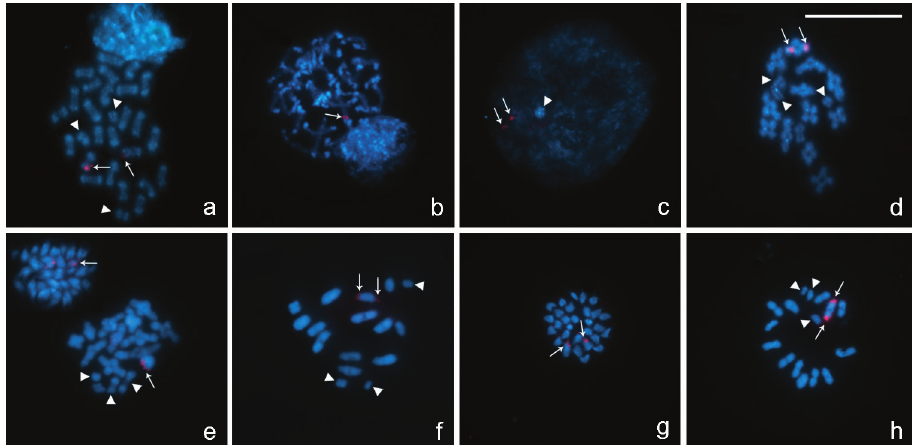
Figure 5. Location of rDNA genes in chromosomes of B. dentatum ( a–d ), B. elongatum ( e, f ) and B. gestroi ( g, h ) by FISH with 18S rDNA probes (red signals, arrows). Chromosomes were counterstained with DAPI (blue). a Spermatogonial anaphase (2n = 29 = 26 + X akinesis e Spermatogonial metaphase and diakinesis f Metaphase I g Spermatogonial metaphase (2n = 29 = 26 + X X Y) h Diakinesis-Metaphase I. Arrowheads show sex chromosomes. Bar = 10 1 2